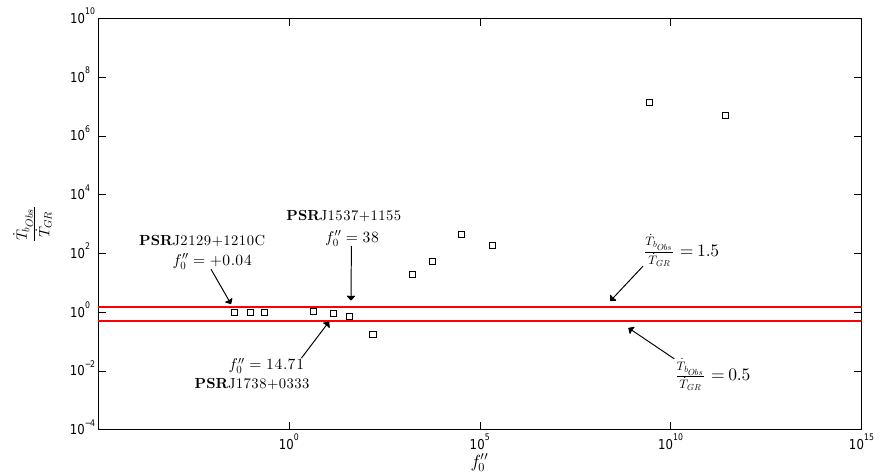
Figure 1: In figure there are shown, for sake of convenience, in logaritmic scale, the absolute values of f (cid:48)(cid:48) ˙ T bObs reported in Tab. 1 versus the ratio . We must note that for five binaries the ETGs we are probing is ˙ T GR not ruled out 0 . 04 ≤ f (cid:48)(cid:48) ≤≈ 38, for those systems the difference between ˙ T GR and ˙ T b 0